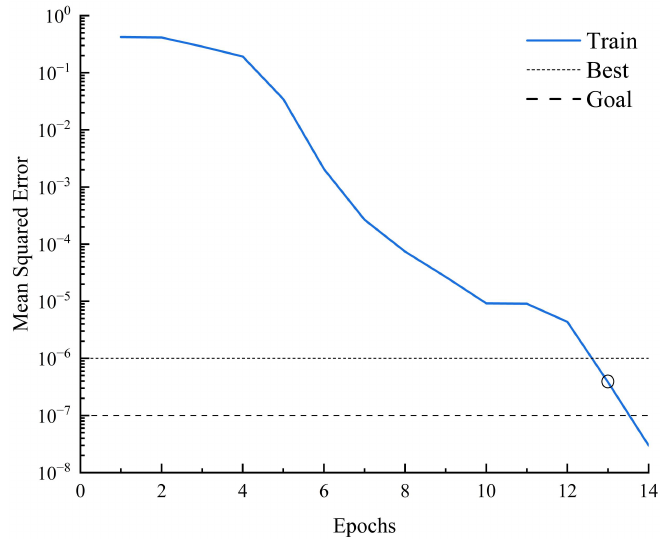
Figure 5. Error convergence curve.